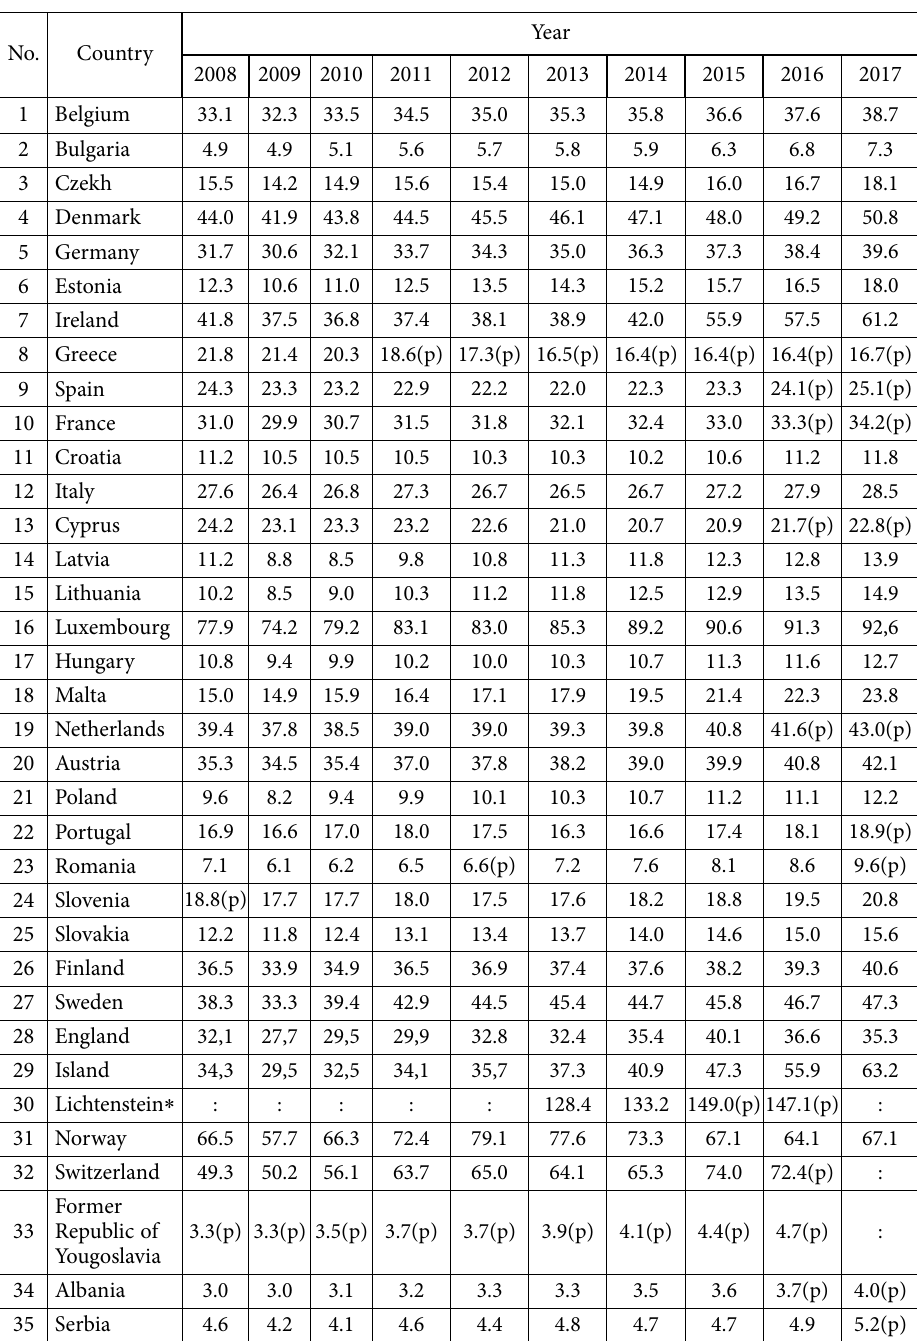
Table 2. EU Gross Domestic Product per capita 2008–2017 (source: Eurostat, n.d.)